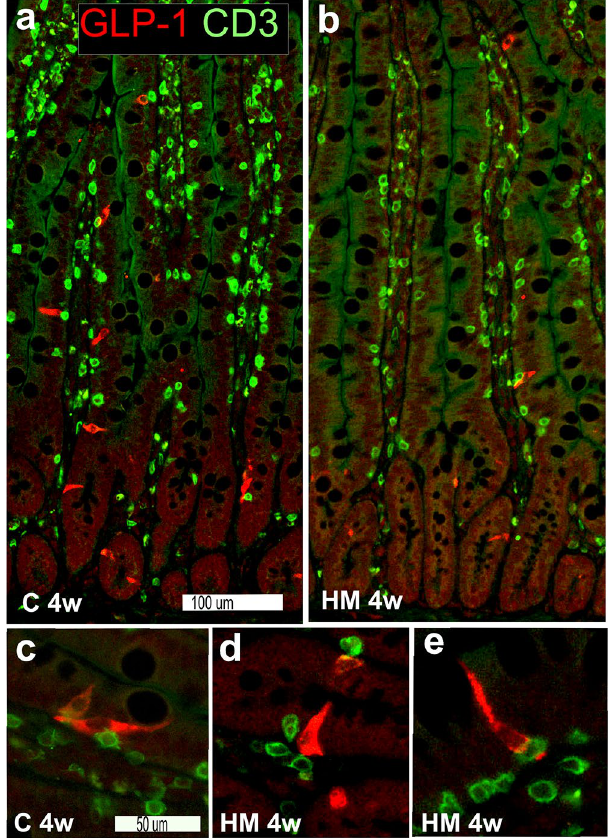
Figure 4. Topographic distribution and proximity of glucagon-like peptide-1 (GLP-1)- (red) and CD3-IR (green) intestinal cells in sections from distal small intestine from rats fed control (C) or high Maillard (HM) diets for 4 weeks (4w) ( a , b ). GLP-1-IR cells are regularly found in both villi and crypt epithelium, particular in C diet rats. CD3-IR cells are numerous throughout the mucosa, in lamina propria as well as intraepithelial, in both C ( a ) and HM ( b ) diet rats. Scale bar is 100 μm and applies to a and b. Note frequent close contacts between GLP-1- and CD3-IR cells as shown in higher magnification in both C ( c ) and HM ( d , e ) diet rats. Scale bar in ( c ) is 50 μm and applies to ( c – e